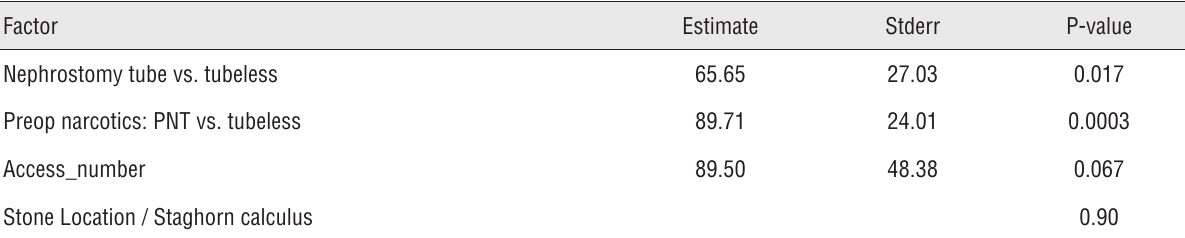
Table 5 - Multi-variable association between the narcotics and PNT, adjusting for pre-op. narcotics, access number, and stone